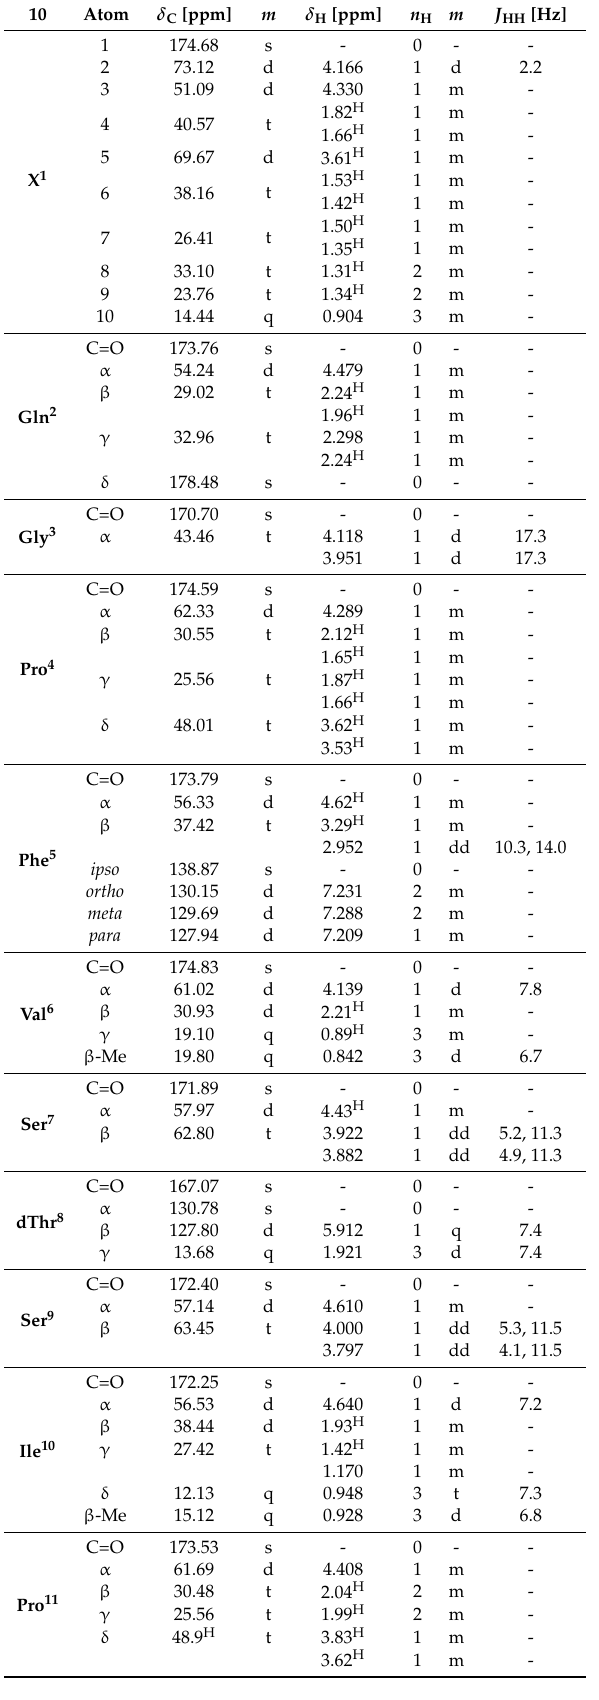
Table 2. 1 H and 13 C-NMR data of 1 (600.13 MHz for 1 H, 150.93 MHz for 13 C, CD3OD, 303.2